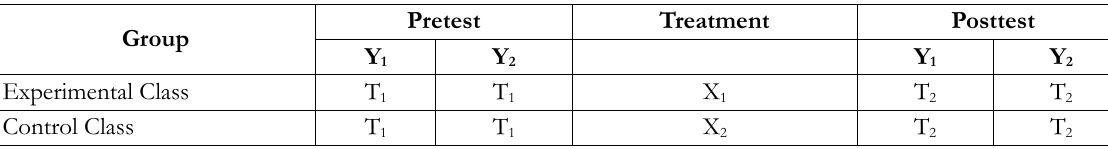
Table 1. Research